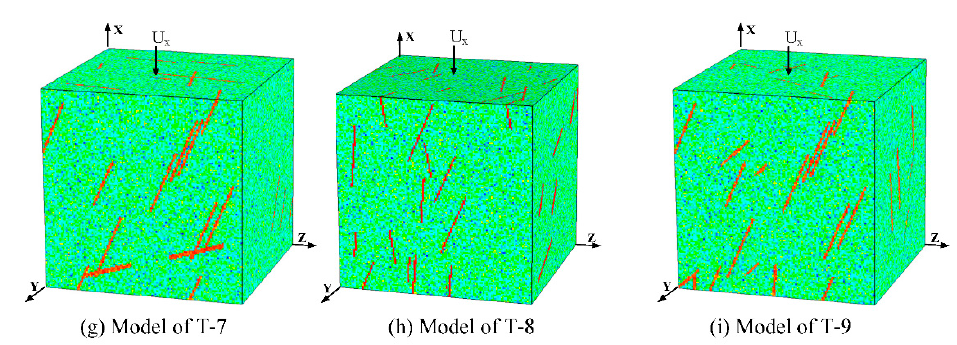
Figure 3. Numerical model of the orthogonal arrays of the test scheme.